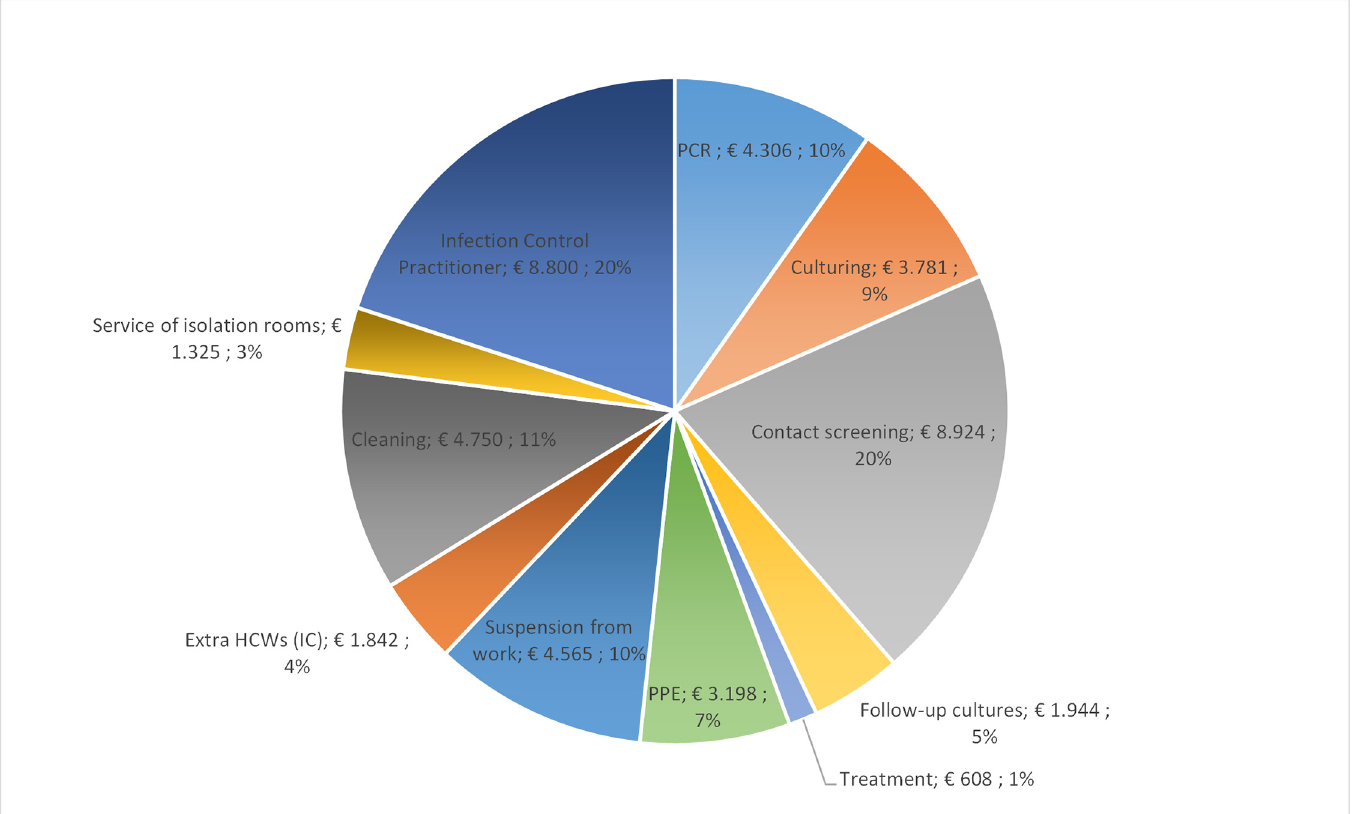
Fig 1. Annually average costs per category for the MRSA Search and Destroy policy in the Kennemer Gasthuis, Netherlands.